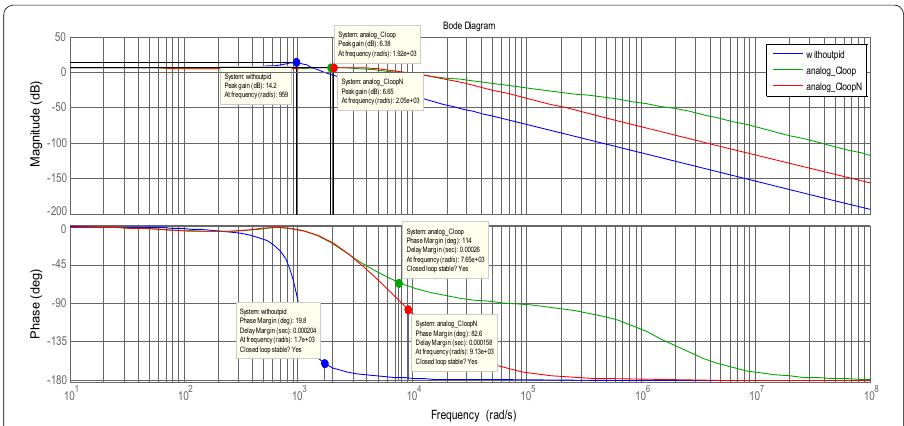
Fig. 9 Frequency response of BBC with PID and PIDN and without PID control in boost mode